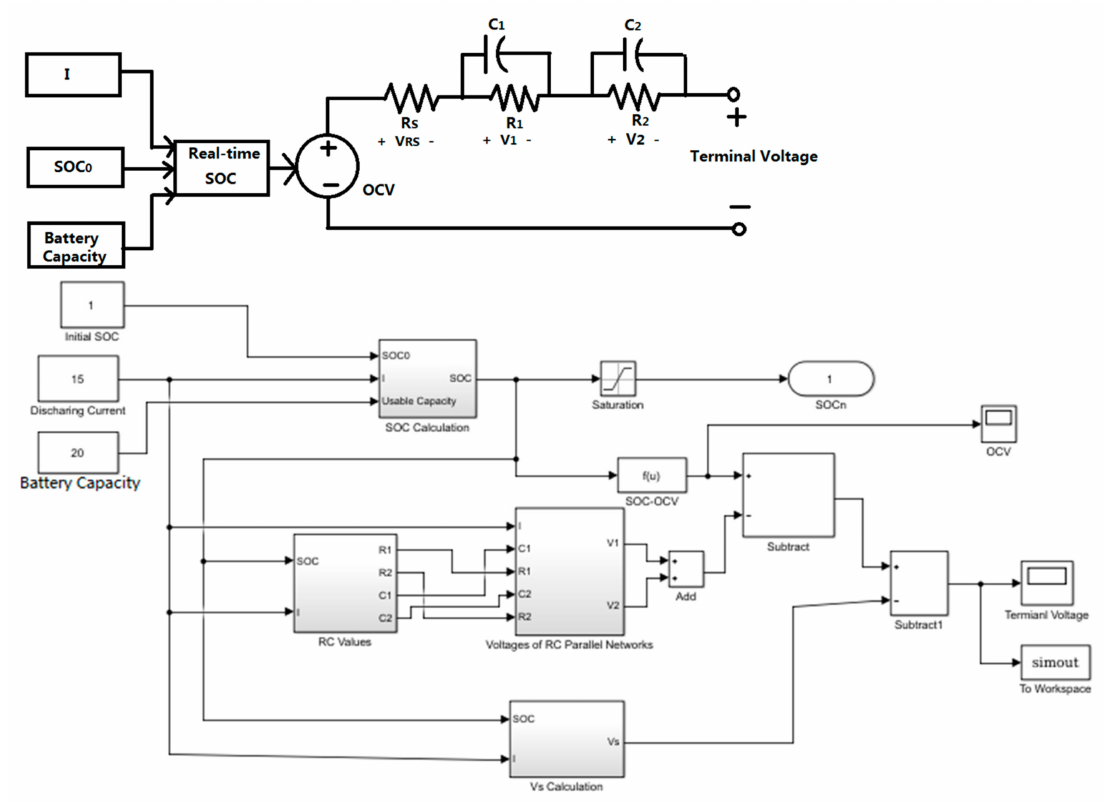
Figure 2. Developed cell model with three